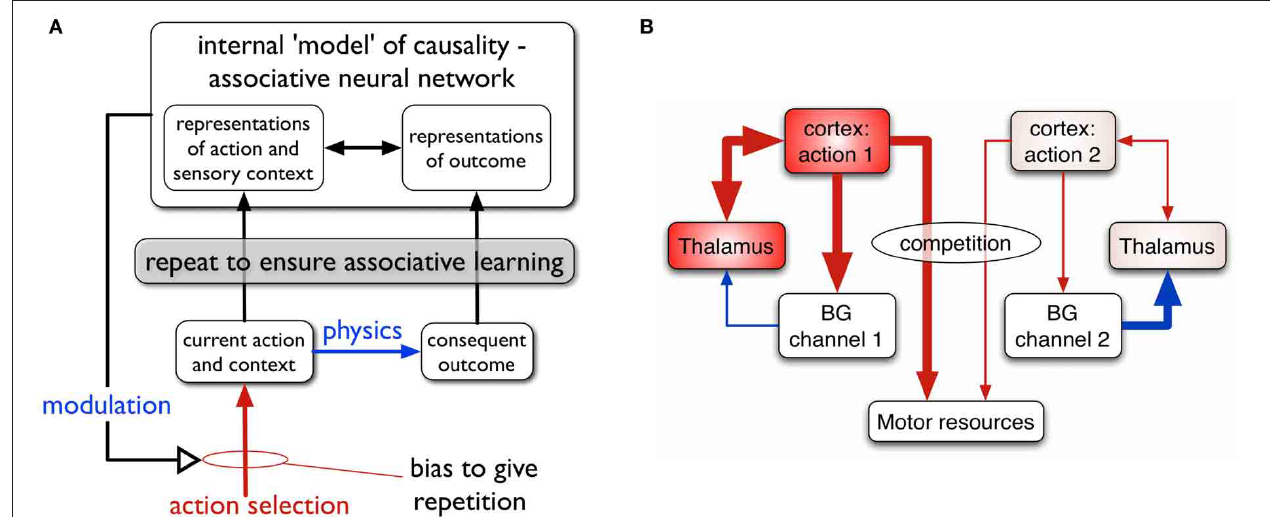
for behavioral expression in basal ganglia which has therefore released inhibition on its thalamic channel target, thereby allowing the corresponding thalamo-cortical loop to build up activity. Blue/red lines show inhibition/excitation, respectively and the width of lines encodes signal